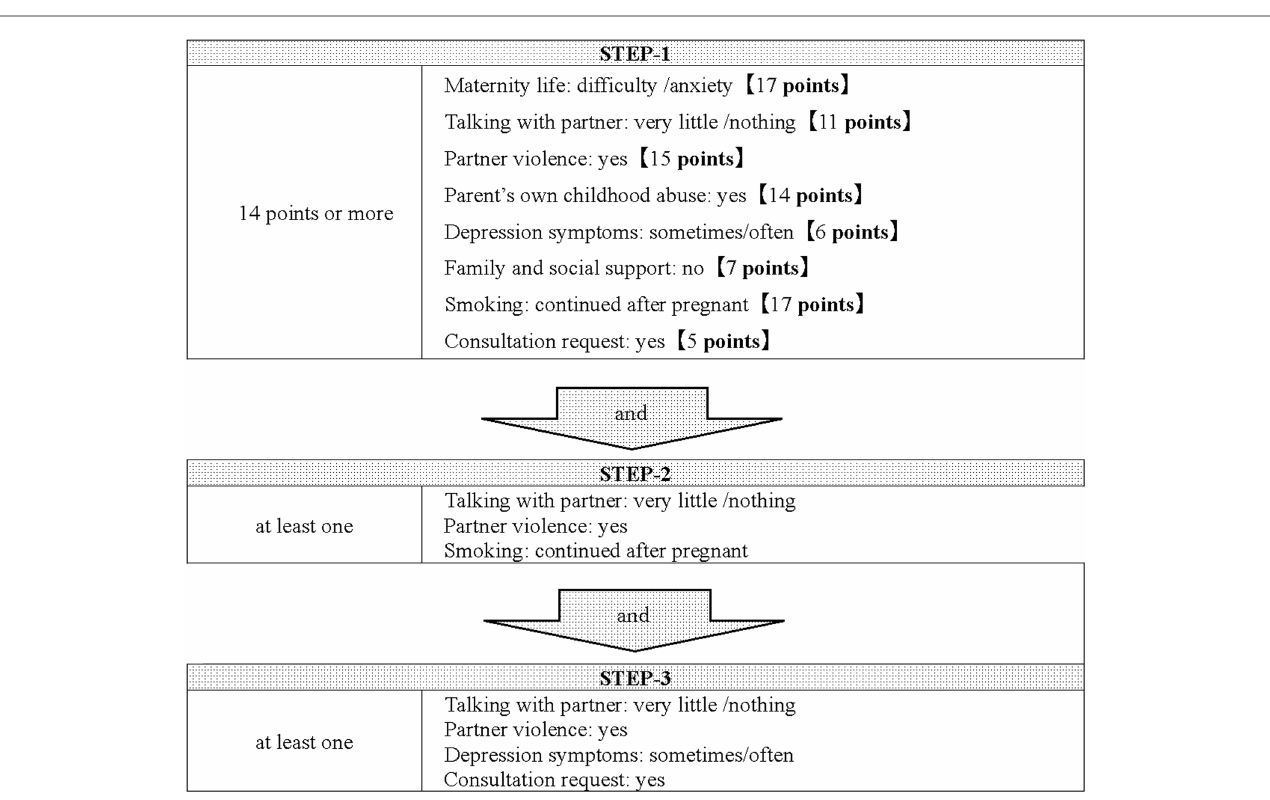
FIGURE 2 The screening tool used at the fi rst visit. Pregnant women with score of 22 points or more were selected as STEP-1. Then, pregnant women are narrowed down as STEP 2 and 3 according to the items on the interview sheet at fi rst